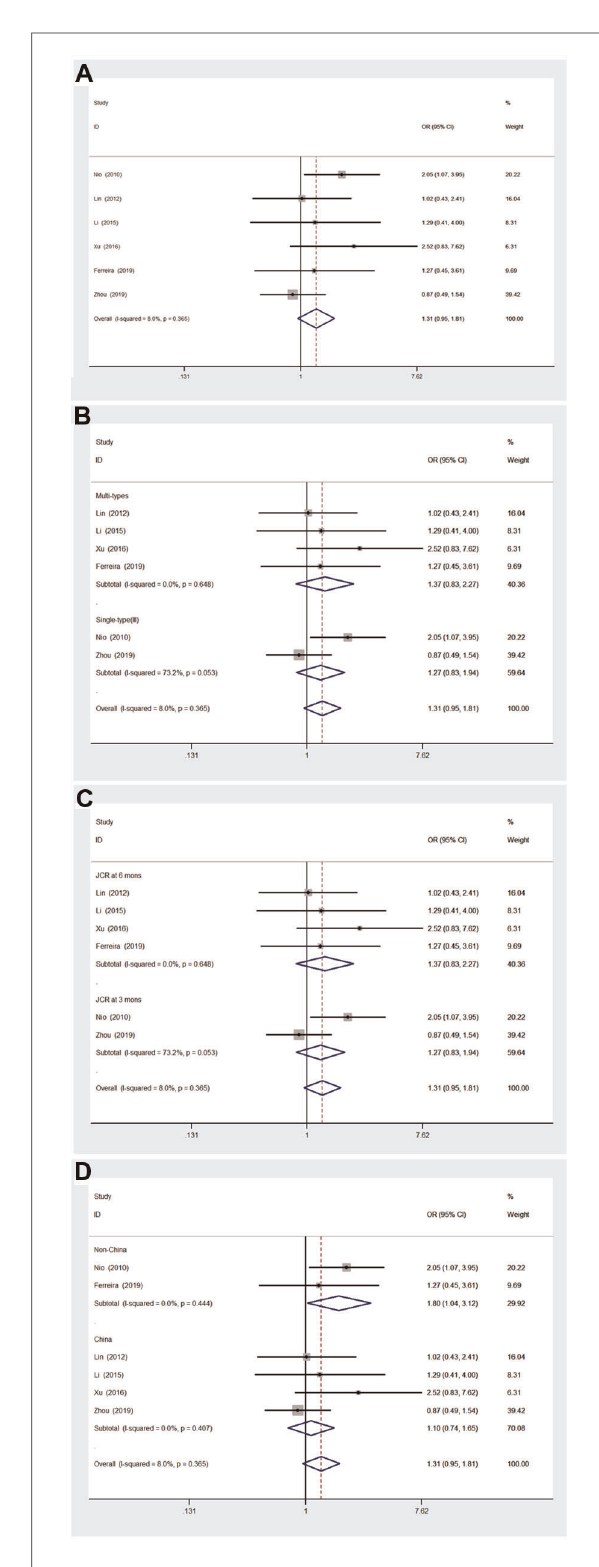
FIGURE 3 Forest plot for JCR of ≤ 60 days vs. 61 – 90 days group and results of subgroup analyses. ( A ) Forest plot for JCR. ( B ) Subgroup analysis based on biliary atresia type. ( C ) Subgroup analysis based on JCR at 3 vs. 6 months. ( D ) Subgroup analysis based on region. JCR, jaundice clearance